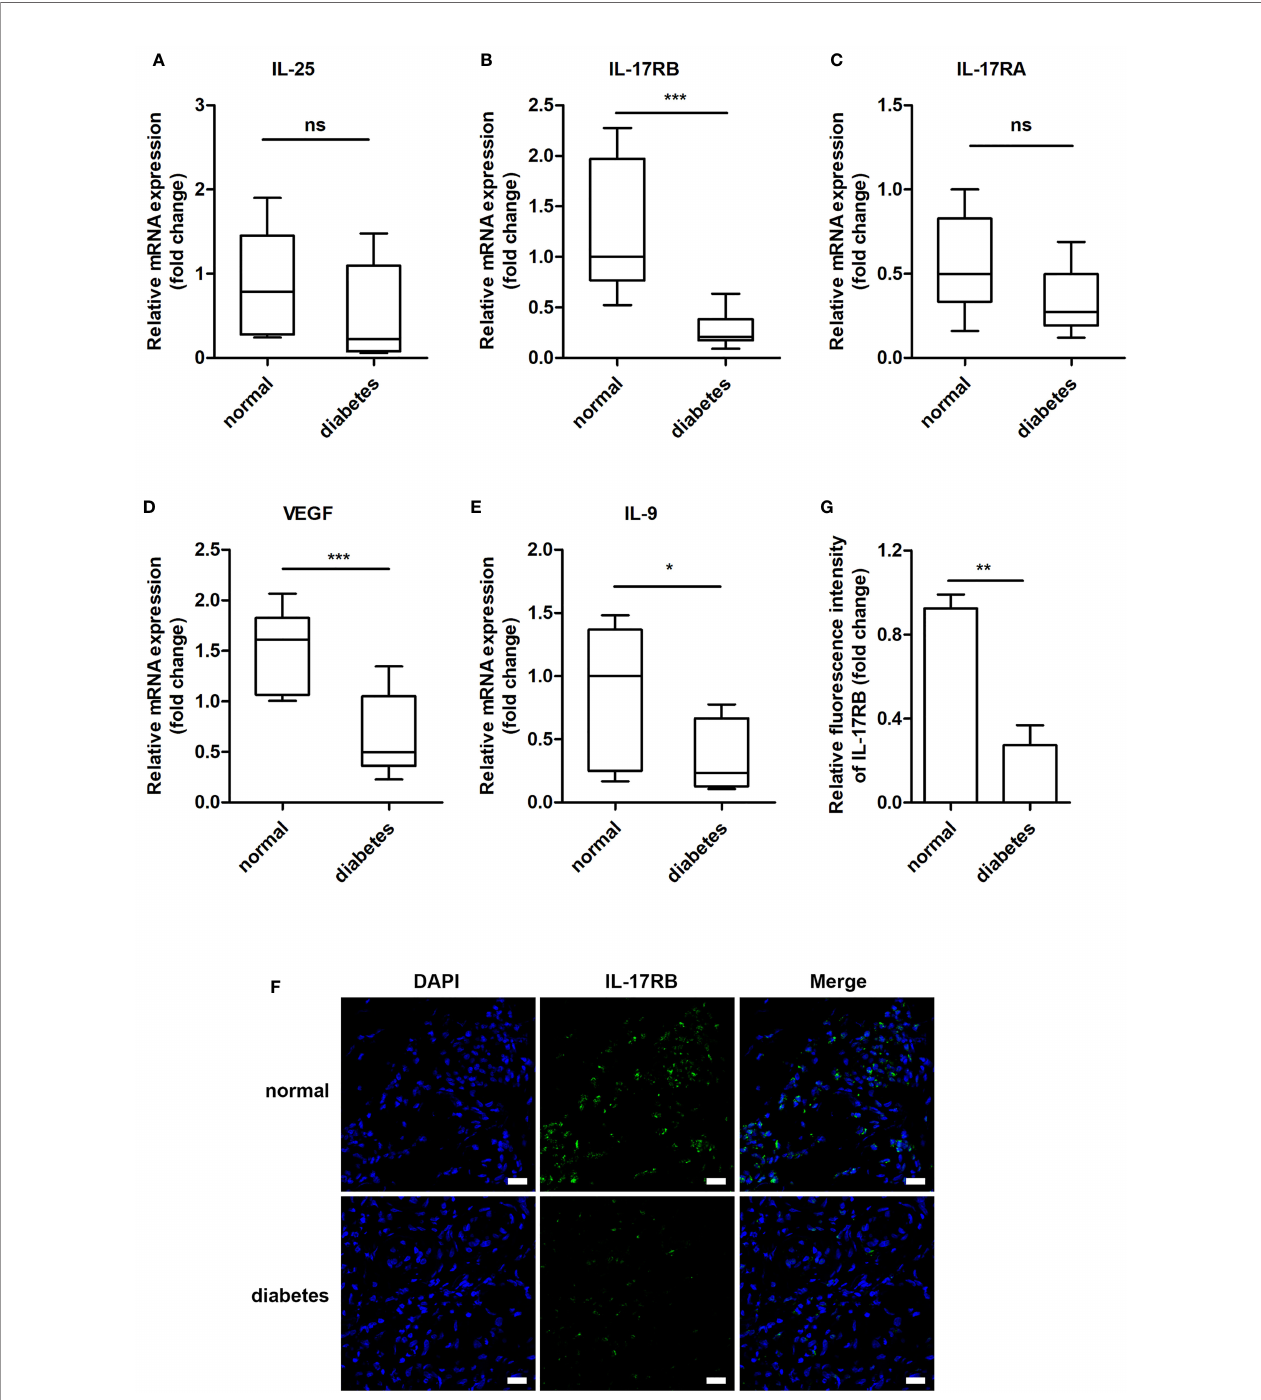
FIGURE 1 | IL-17RB but not IL-17RA is involved in the skin wound healing of patients with DFU. (A – E) Relative mRNA expression of IL-25, IL-17RB, IL-17RA, IL-9 and VEGF in the wound edge skin from diabetic patients with DFU (n = 11) and normoglycemic individuals (n = 7), respectively. (F, G) Representative immuno fl uorescent staining for IL-17RB (green) and DAPI (blue) in the wound edge skin from diabetic patients with DFU and normoglycemic individuals. Scale bars, 20 m m. Quanti fi cation of the IL-17RB protein in the skin is shown in the histogram in G (n = 3, three views for each sample). * P < 0.05, ** P < 0.01, *** P < 0.001. ns, no signi fi